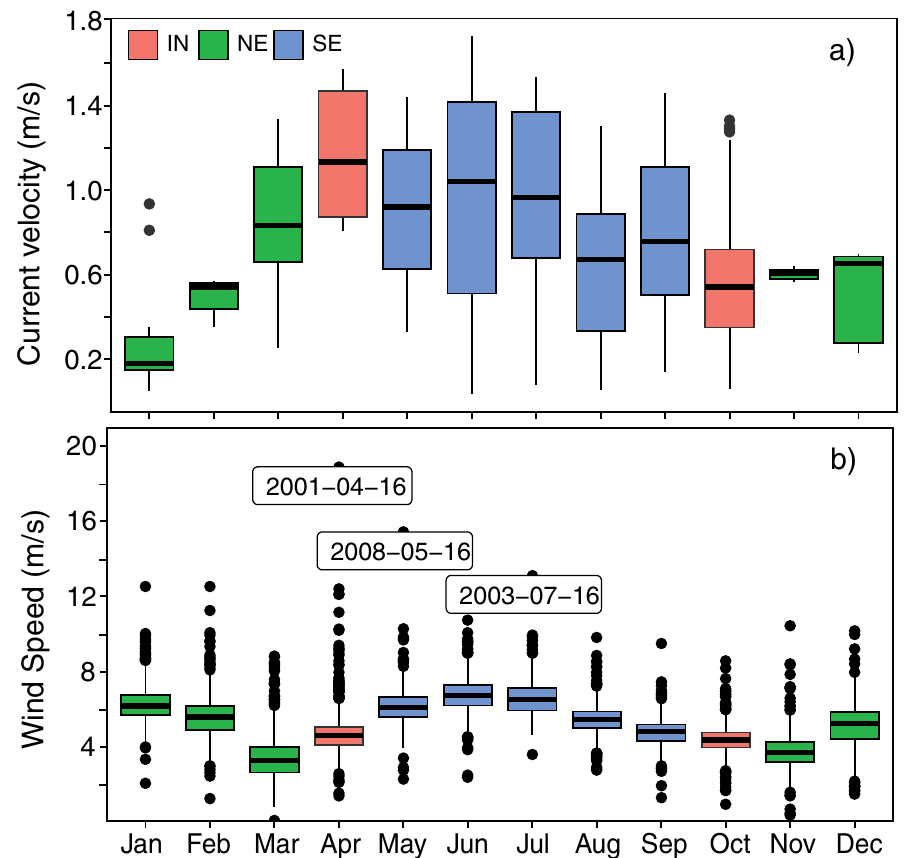
Fig 8. Boxplot showing monthly variation of a) surface current velocity and b) wind speed in the Pemba Channel. The dates show days with anomalous highest wind speeds.